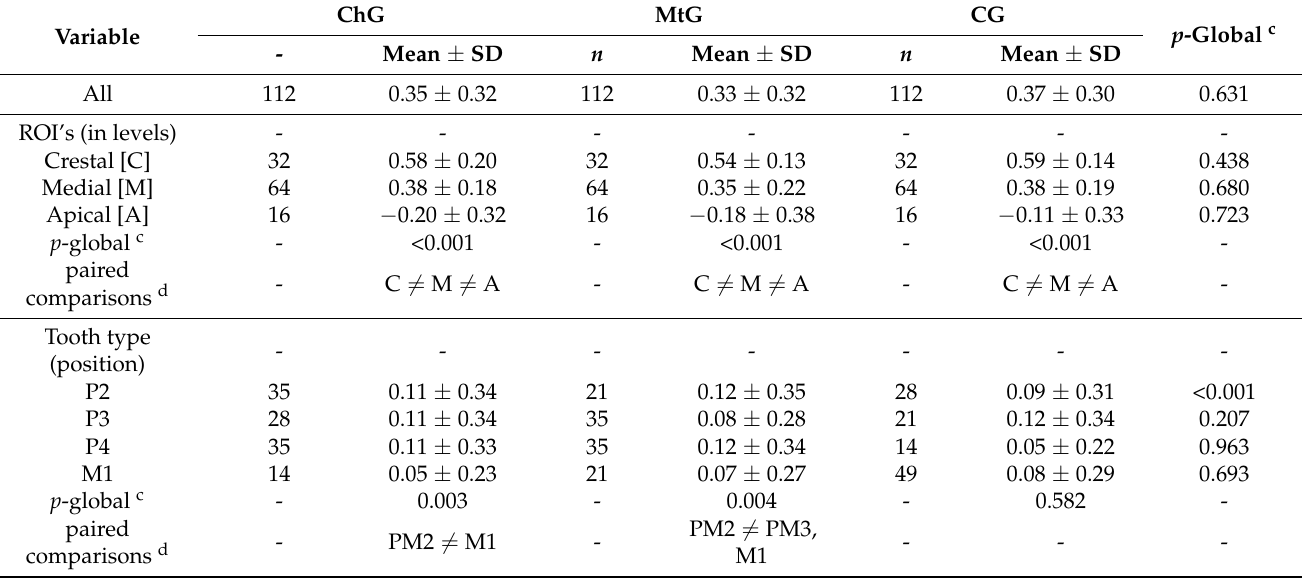
Table 1. Description and comparison of BD measurements studied a in 336 sites b .